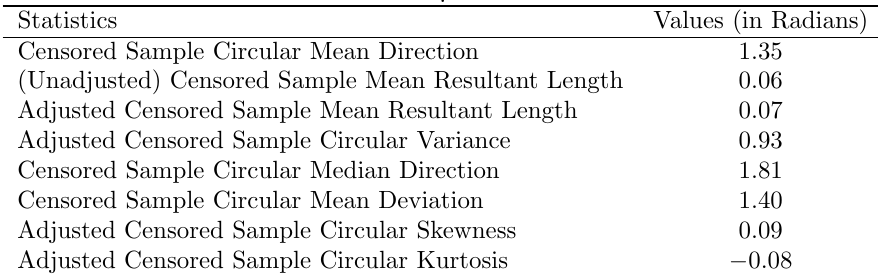
Censored Circular Descriptive Statistics for data shown in Table (2)